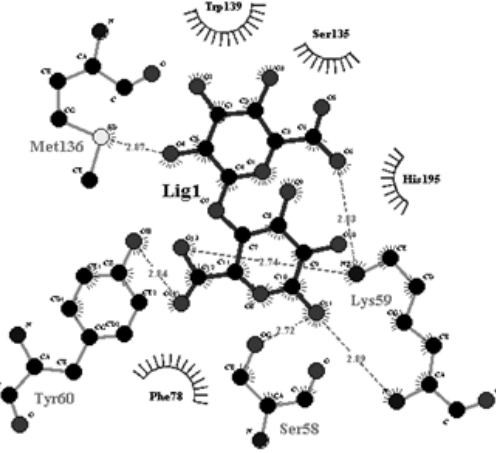
Fig. 5. 2D representation of interactions between P. aeruginosa Alginate Lyase (AlgL) protein and alginic acid ligand using Ligplot. Amino acids Ser58, Lys59, Tyr60, and Met136 participate in hydrogen bonding with the ligand molecule. Phe78, Ser135, Trp139, and His195 of the AlgL are involved in hydrophobic